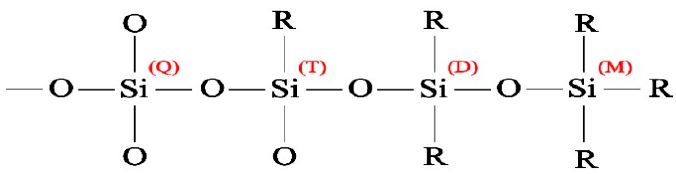
Figure 12. Silicon chemical states in a typical siloxane-based molecular structure. Table 5. Chemical states of silicon in siloxane coatings [58]. Binding